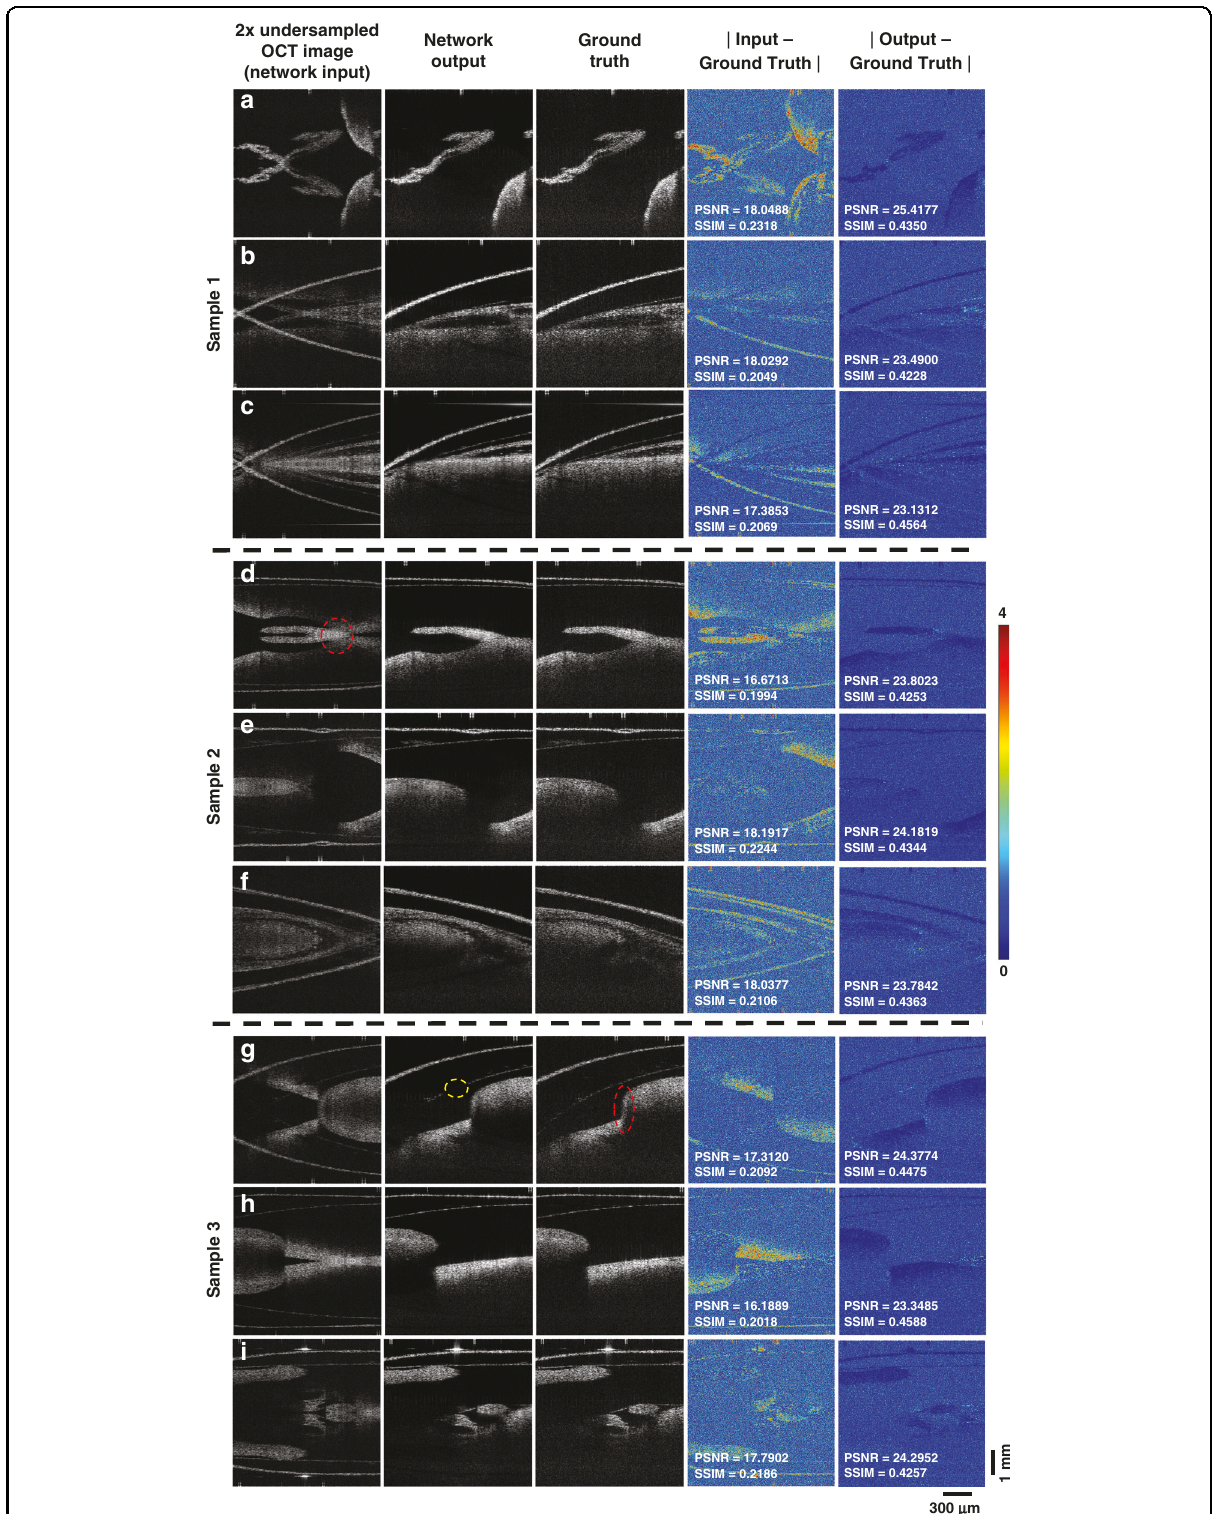
Fig. 2 Blind testing performance of the DL-OCT framework. The network input, output, and ground-truth images of three mouse embryo samples (never seen by the network before) at different fi elds-of-view are shown in the fi rst three columns. The error maps of the input and output with respect to the corresponding ground-truth image are provided in the 4th and 5th columns, respectively. The peak signal-to-noise ratio (PSNR) and structural similarity index (SSIM) values were also computed and displayed for each one of these sample fi